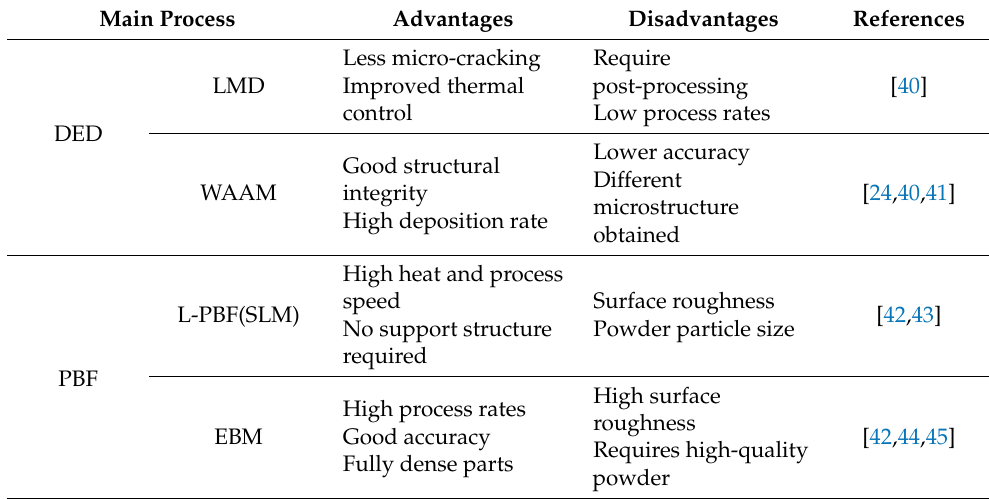
Table 1. Main advantages and disadvantages of DED and PBF AM